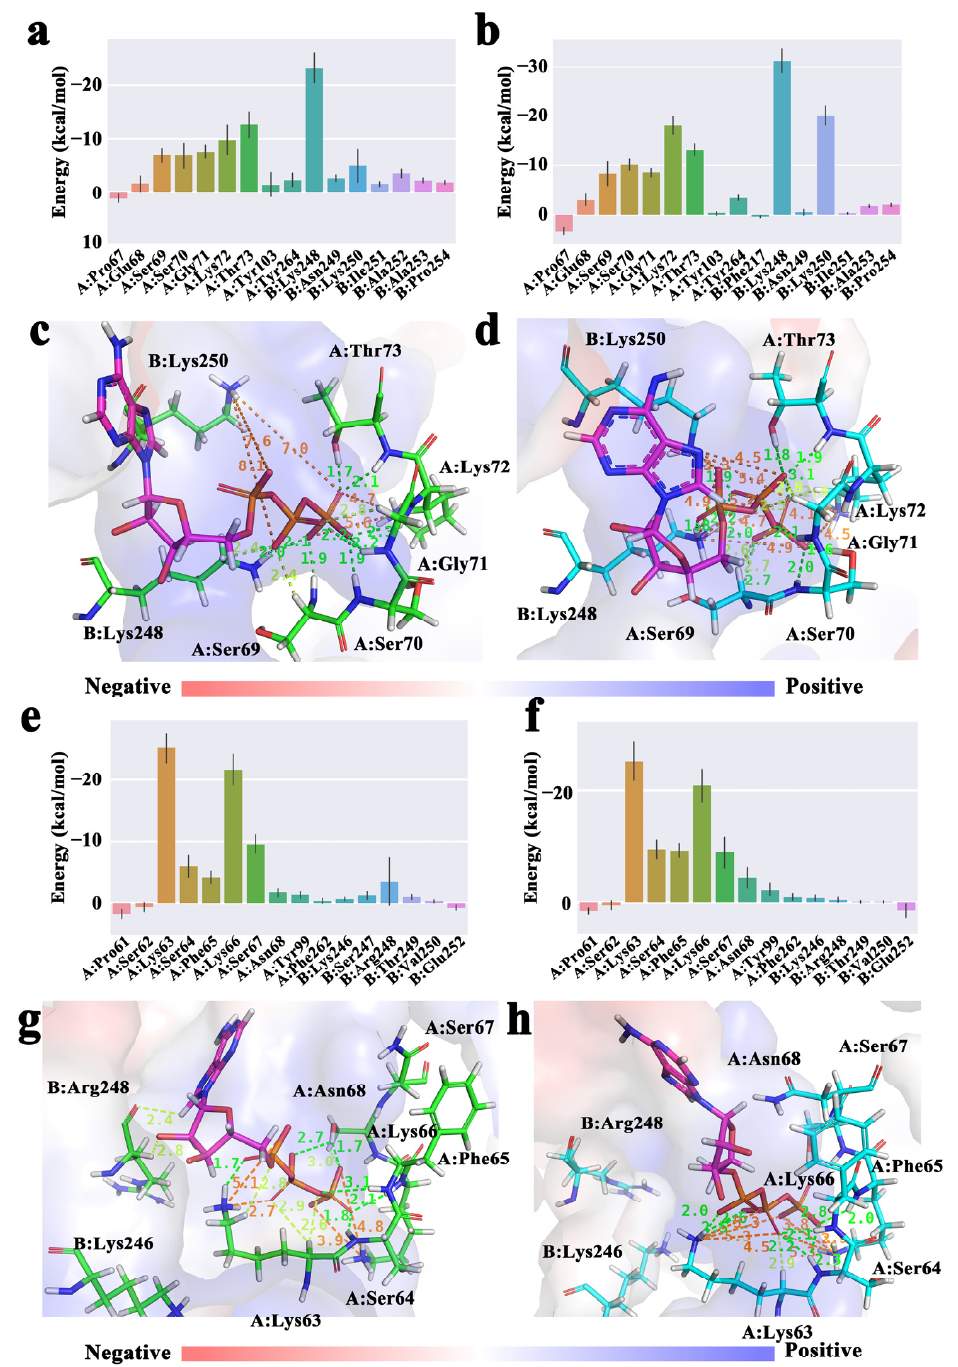
Figure 5. Energy contribution of ATP binding residues in RecA ( a ) 298 K, ( b ) 310 K. Schematic diagram of ATP interacting with RecA ( c ) 298 K, ( d ) 310 K. Energy contribution of ATP binding residues in UvsX ( e ) 298 K, ( f ) 310 K; Schematic diagram of ATP interacting with UvsX ( g ) at 298 K, ( h ) at 310 K. (The dashed green lines represent conventional hydrogen bond interactions, the lemon lines represent carbon hydrogen bonds, and the orange lines represent electrostatic interactions and bond lengths in Å.).